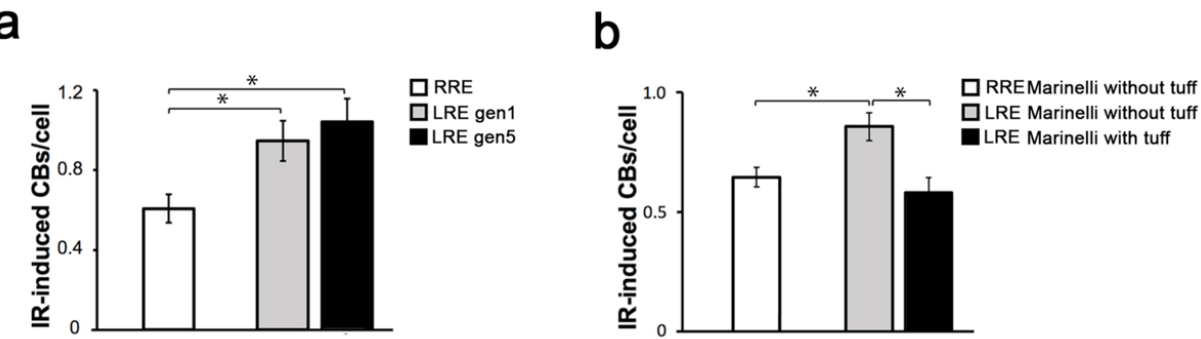
Figure 2. Effects of radiation background on IR-induced CBs. ( a ) Average number of CBs per cell induced by gamma rays in neuroblasts from Oregon-R third instar larval brains analyzed after 4 h post-irradiation with the acute dose of 10 Gy. Net data are reported, after subtraction of the control values. CB frequency was analyzed in Oregon-R larvae from generations 1 and 5. ( b ). Average number of CBs per cell induced by gamma rays in larvae kept for 7 days in the Marinelli beakers with tuff (irradiator) or without tuff (phantom) at both LRE and RRE and then exposed to the acute dose of 10 Gy. At least three independent experiments were performed for each condition. The error bars represent the standard error of the mean. Values of p < 0.05 (*) were considered as statistically significant ( t -test). In our experiments, we observed a frequency of CBs in the control samples (not irradiated with the acute dose) ranging from 0.03 to 0.15 CBs per cell. CBs: Chromosome Breaks; LRE: Low Radiation Environment; RRE: Reference Radiation Environment.